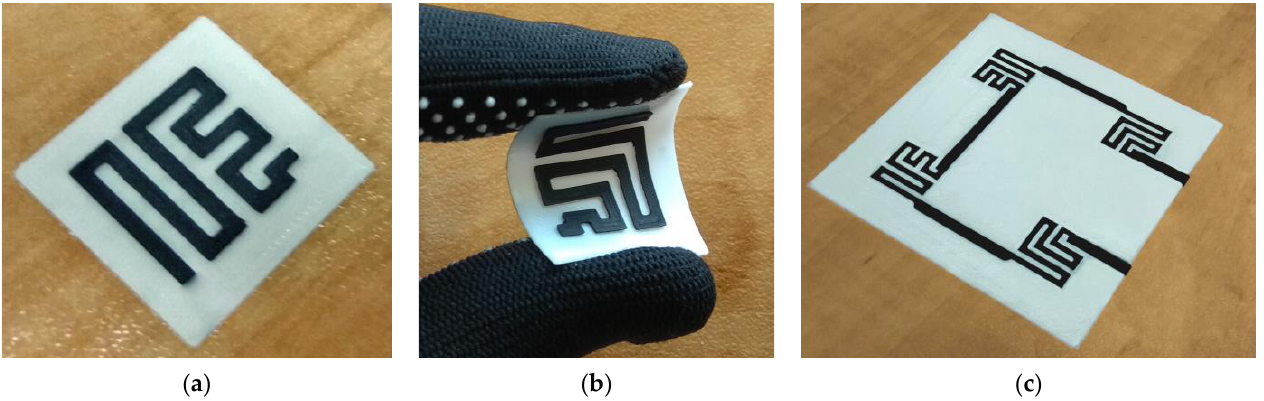
Figure 3. The printed temperature detectors: ( a ) sensor with perpendicular contacts, ( b ) sensor with parallel contacts and ( c ) rectangular surface with four sensors embedded in a flexible substrate.